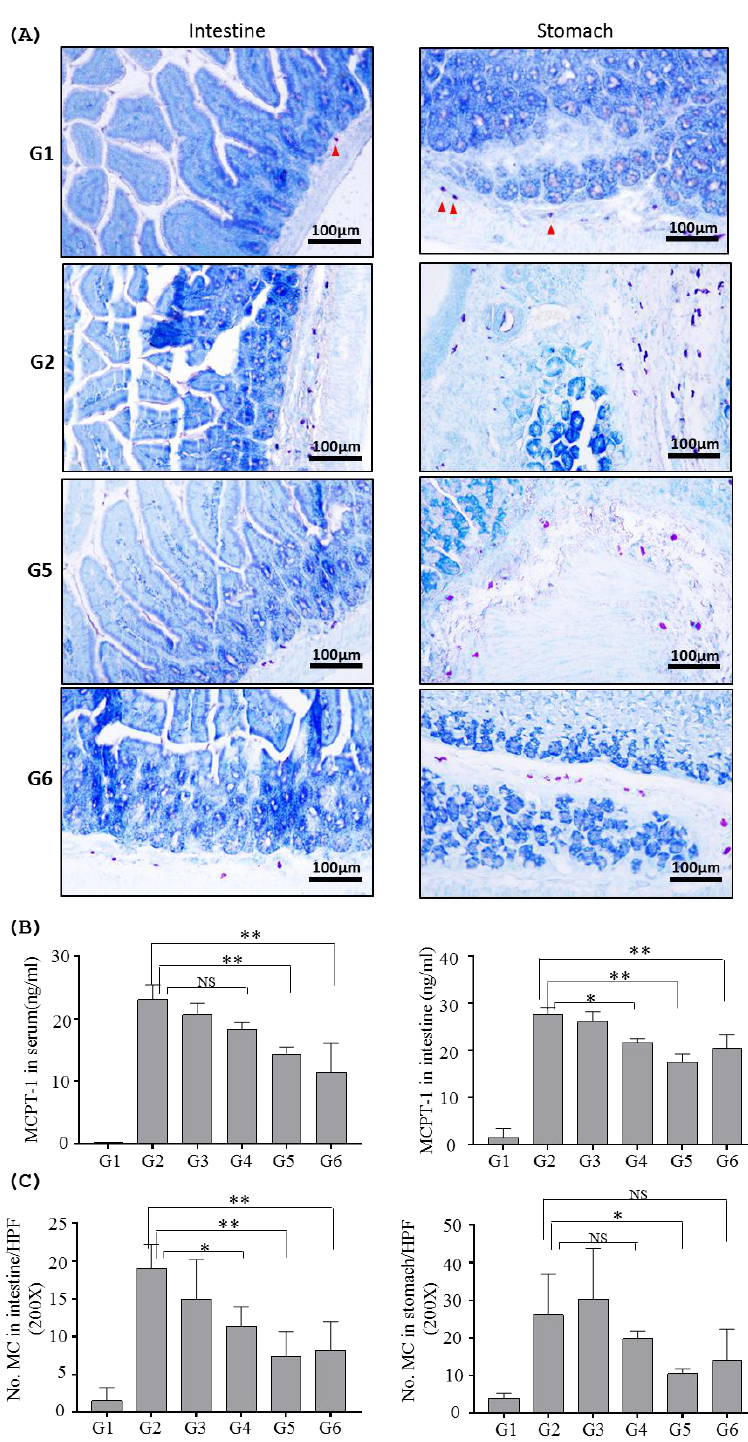
Figure 7. Inhibition by INO95 and INO20 on the function of mast cells in food allergic mouse model. Mice were sacrificed on day 42. Serum was harvested to measure MCPT-1, and small intestine, stomach were collected to analyze cytokine production and histology. ( A ) Mast cells in tissues were determined by toluidine blue staining and counted at magnification of ×200. ( B ) MCPT-1 levels were measured in both serum and tissue extraction. ( C ) Mast cells indicated by red arrow were counted in each group. Significantly different from sham group p < 0.05 (*), p < 0.005 (**), as determined by one way ANOVA test. The data shown represent mean ± S.D. ( n = 4).